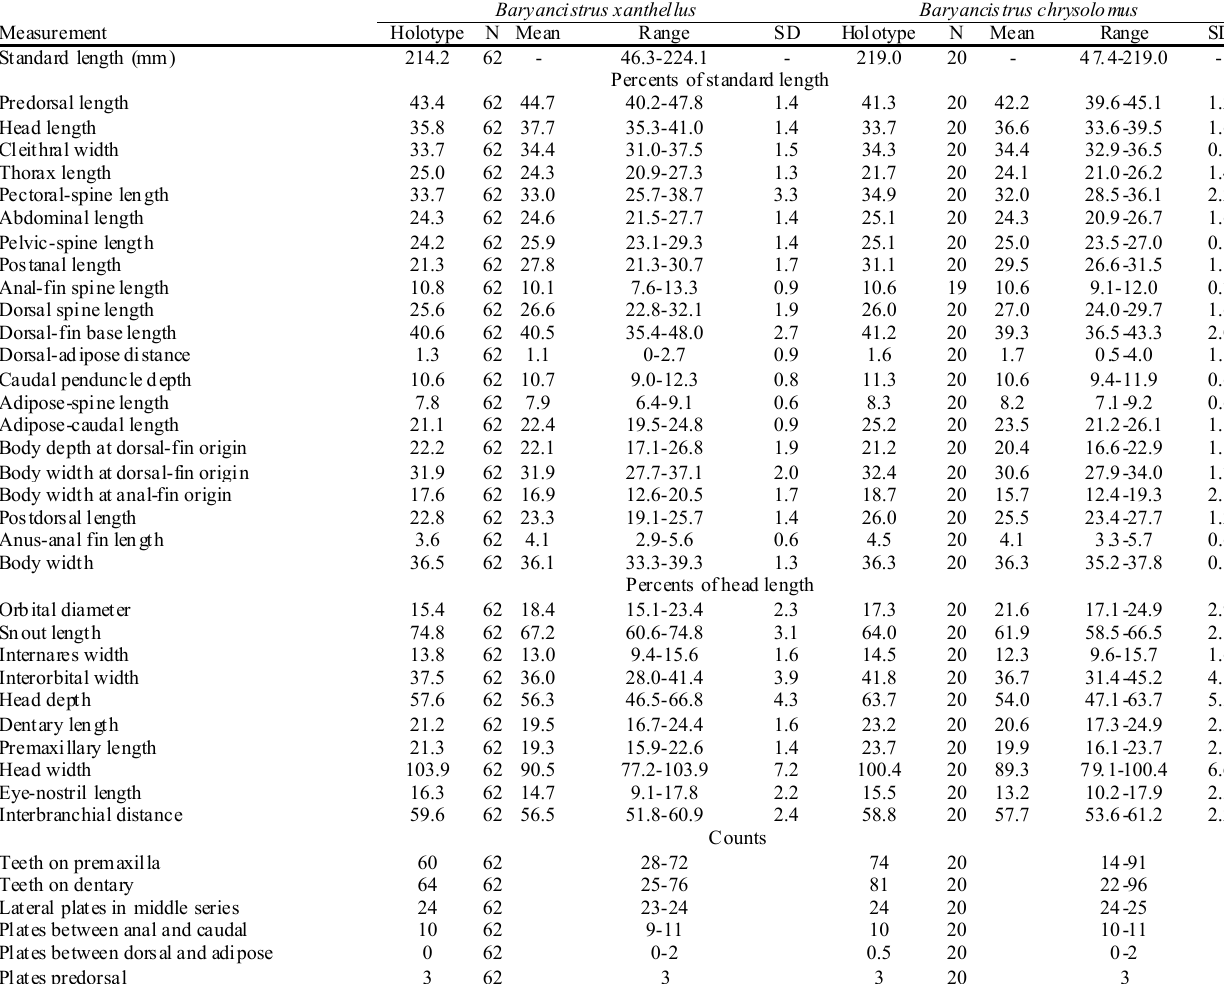
Table 1. Morphometric and meristic data of Baryancistrus xanthellus and Baryancistrus chrysolomus . Baryancistrus